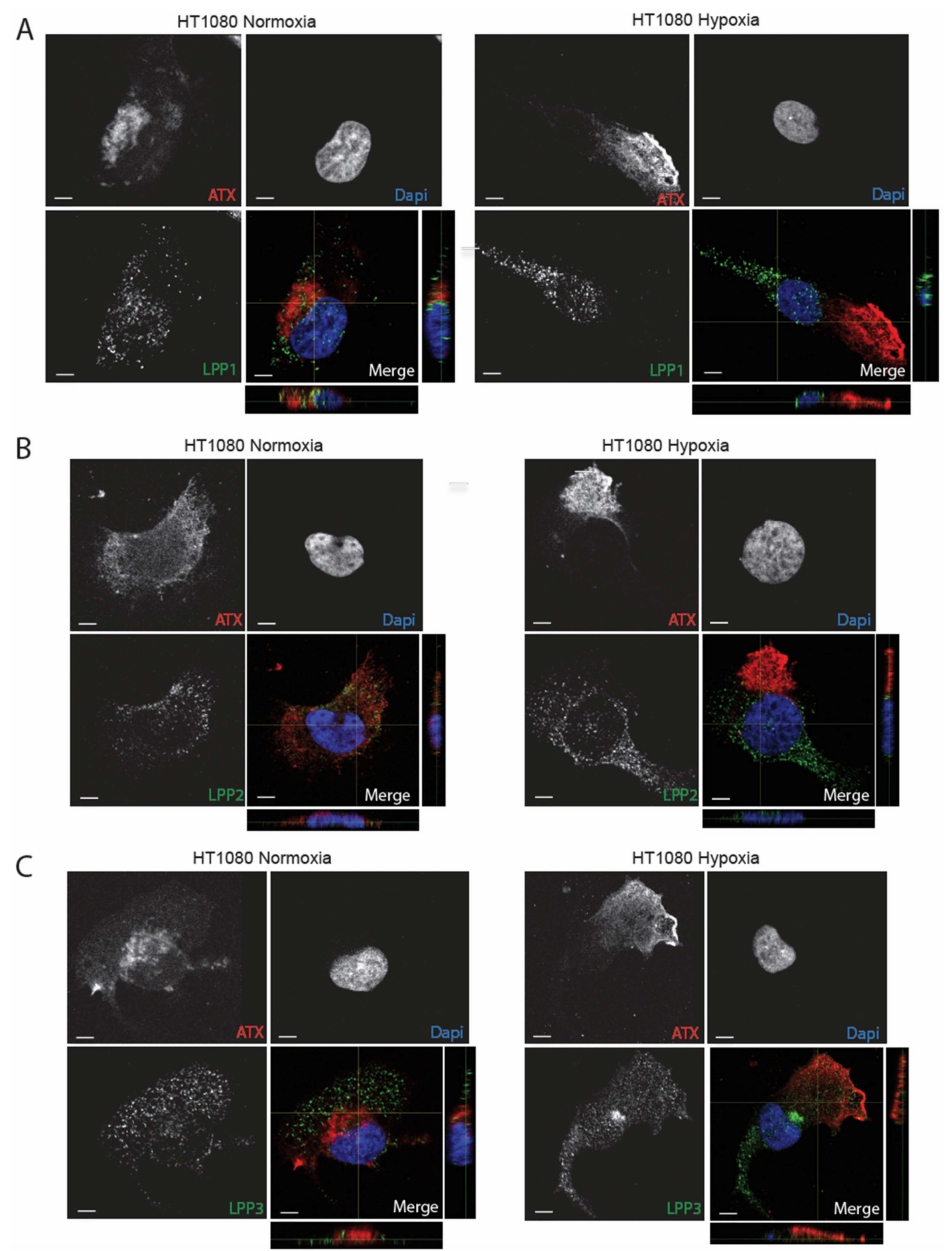
Figure 5. Localization of both ATX and LPPs in hypoxic cancer cells. ( A – C ) Representative immunofluorescence images of HT1080 cells cultured on non-fluorescent gelatin for 4 h in normoxia (21% O 2 ) or hypoxia (1% O 2 ) are shown. Cells were stained for ( A ) LPP1, ( B ) LPP2, or ( C ) LPP3 (green) and ATX (red). Nuclei were stained with DAPI (blue). Magnification 60 × , scale bars, 5 µ